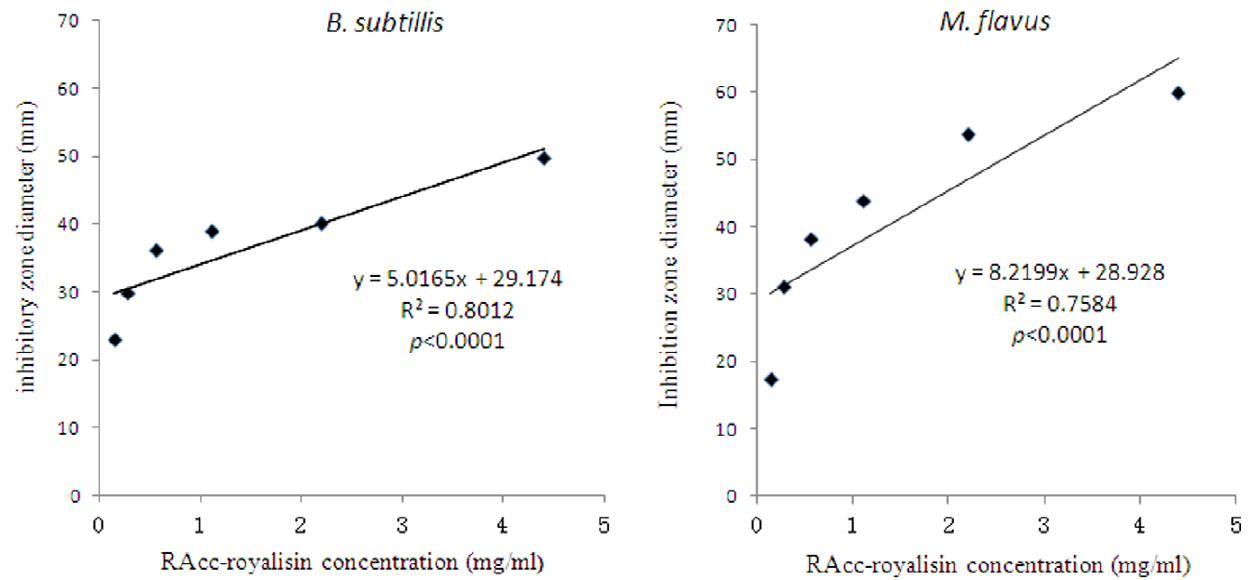
Figure 3. Correlation between RAcc-royalisin concentration and antibacterial activity against Gram-positive bacterial strains. Correlation between RAcc-royalisin concentration and antibacterial activity against B. subtilis (A) and M. flavus (B).